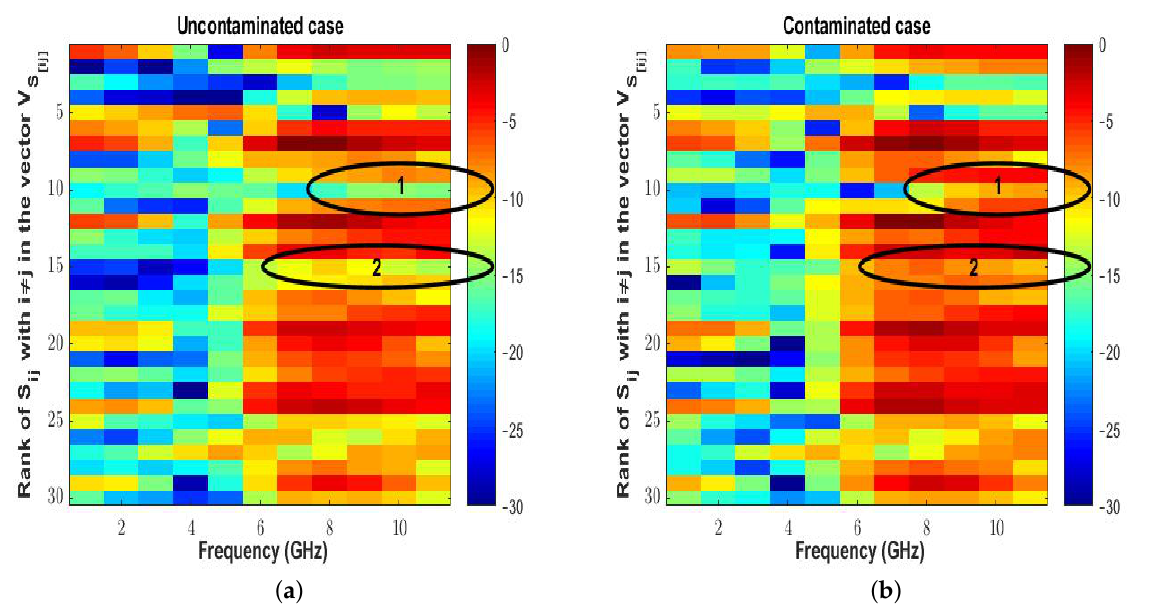
Figure 4. Plotting of the amplitude of the retrieved S-parameters from two samples under test. ( a ) The uncontaminated jar sample; ( b ) the contaminated jar